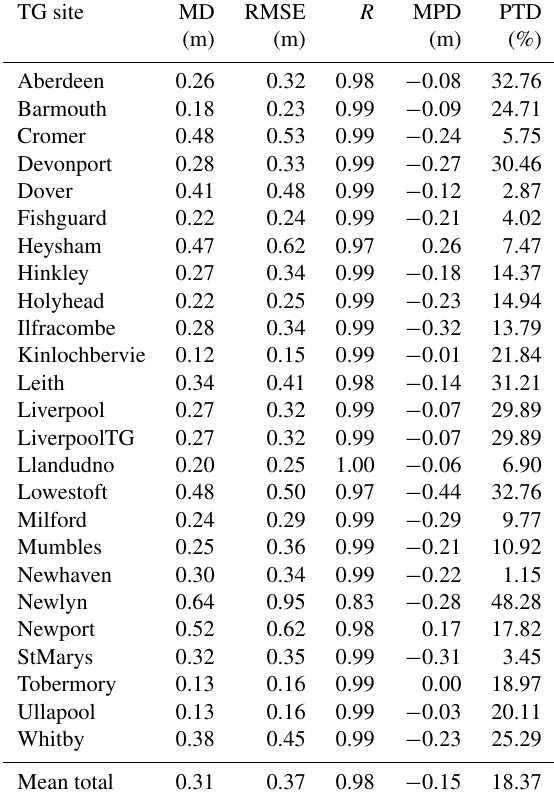
Table A1. Comparison of TWL to TGs from 1 December 2013 to 28 February 2014. To assess against observations with a higher tem- poral frequency than model outputs, both the TG and the model data are interpolated to 1min time series and then re-averaged within the hour. In some cases, we found an offset of 1h in the peak time from model and observation. The percentage of peaks misrepresented by the model is shown in the last column. In nearly all these cases the model peaks occur 1h earlier than in observations. The columns show the TG site names, the mean absolute difference between the model minus the TG (MD), the root-mean-square error (RMSE), the correlation ( R ), the mean peak magnitude difference (MPD), and the number of cases in which the model peaks were offset in time compared to that of TGs, i.e. the peak time difference